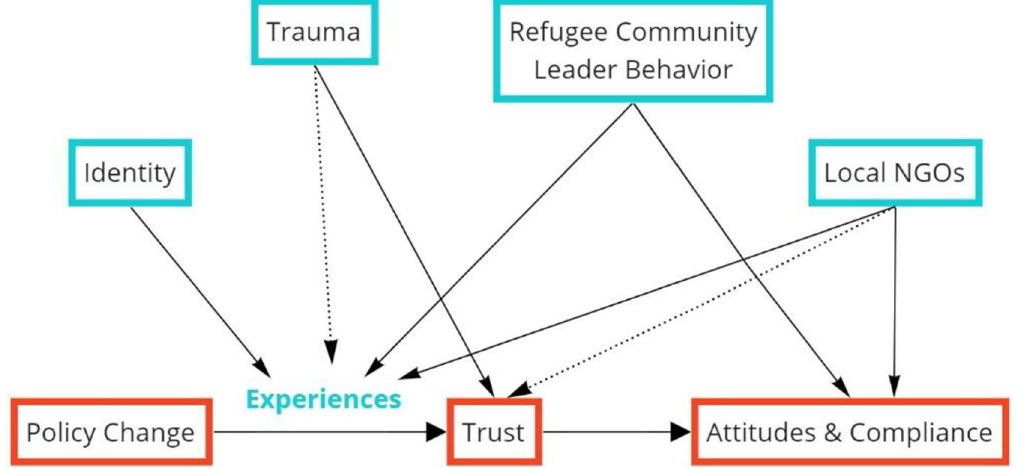
Fig 2. A process model of a refugee’s experience starting from the implementation of the MCO. The arrows represent associations between two factors, the solid lines represent strong association, and dotted lines represent modest association.